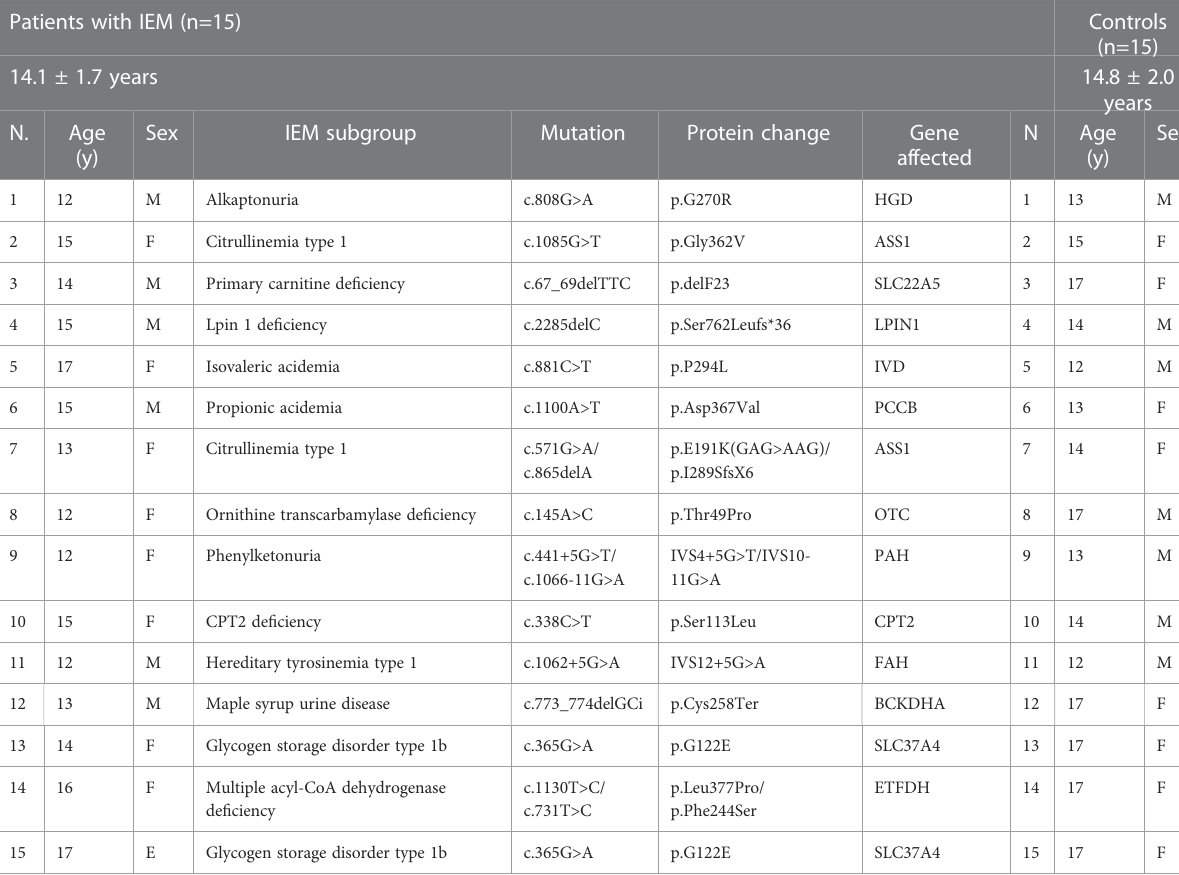
TABLE 1 Demographic data and characteristics of patients and controls. Patients with IEM